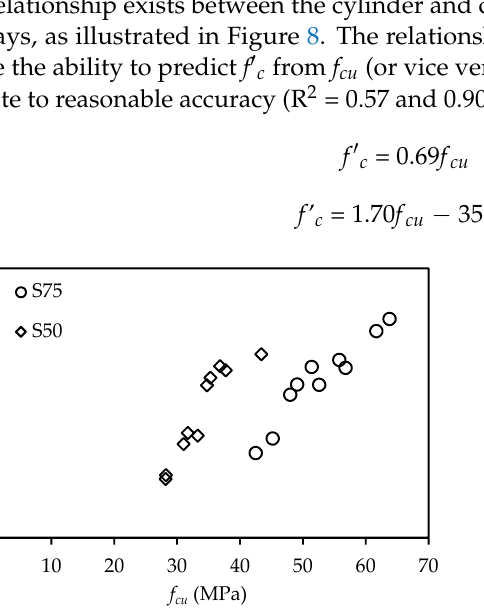
Figure 8. Relationship between cubic and cylinder compressive strength.